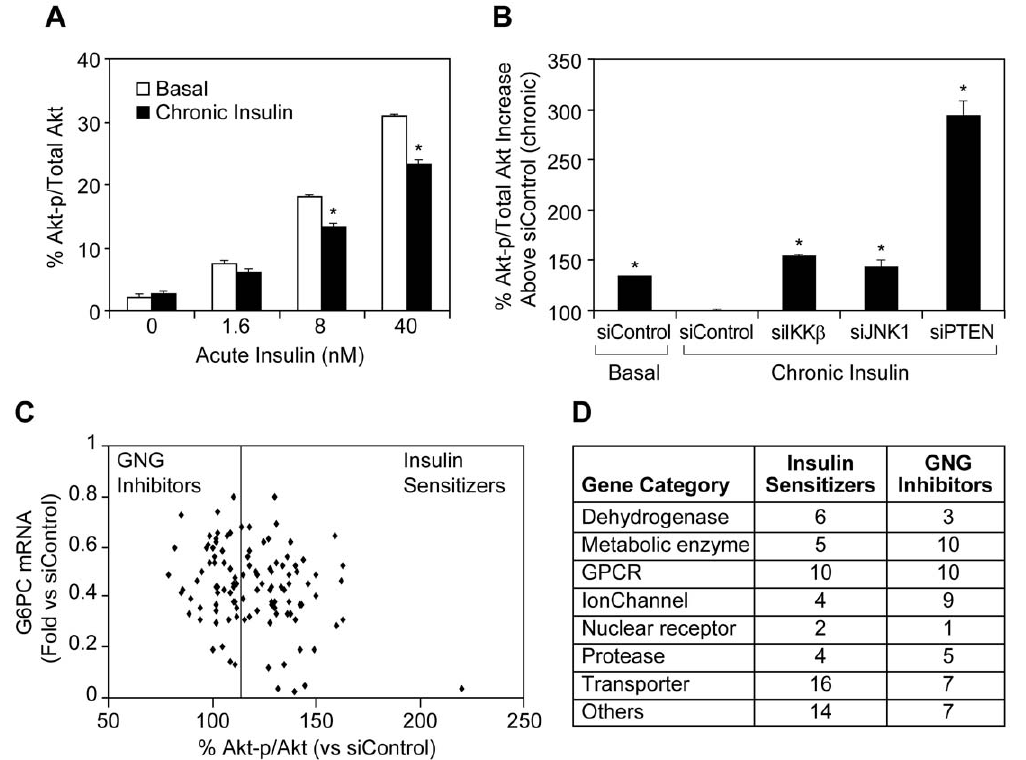
Figure 6. Identification of insulin sensitizer and GNG inhibitor genes. A. Chronic (16 h) 100 nM insulin pretreatment reduces acute (15 min) insulin induction of Akt phosphorylation (Akt-p) in AH-G6PC cells. Akt-p data are presented as the means 6 SEM of % Akt-p/total Akt from a representative experiment performed in triplicate. B. Pooled siRNAs targeting JNK1, IKK b , or PTEN significantly potentiates acute insulin-induced Akt- p after chronic insulin preincubation. Akt-p data are presented as the % Akt-p/total Akt relative to siControl-transfected cells (set as 100%) in response to acute insulin treatment after chronic insulin preincubation and are the means 6 SEM of a representative experiment performed in triplicate. C. Differential impact of pooled siRNAs targeting each of the 113 genes described in figures 5C and 5D in regulating G6PC mRNA expression vs. potentiating insulin-induced Akt-p. Hits were separated into insulin sensitizers and GNG inhibitors that augmented acute insulin induction of Akt-p by more and less than 15% (vertical line), respectively. Akt-p data are presented as the % Akt-p/total Akt relative to siControl-transfected cells (set as 100%) in response to acute insulin treatment after chronic insulin preincubation and are the means of 3 independent experiments. G6PC mRNA expression data were obtained from figures 5C and 5D. D. Table summarizing the number of insulin sensitizer and GNG inhibitor hits in distinct druggable gene categories. Figure 6D quantitatively summarizes the wide variety of druggable gene categories found within the insulin sensitizer and GNG inhibitor target groups identified by our siRNA screening procedure.